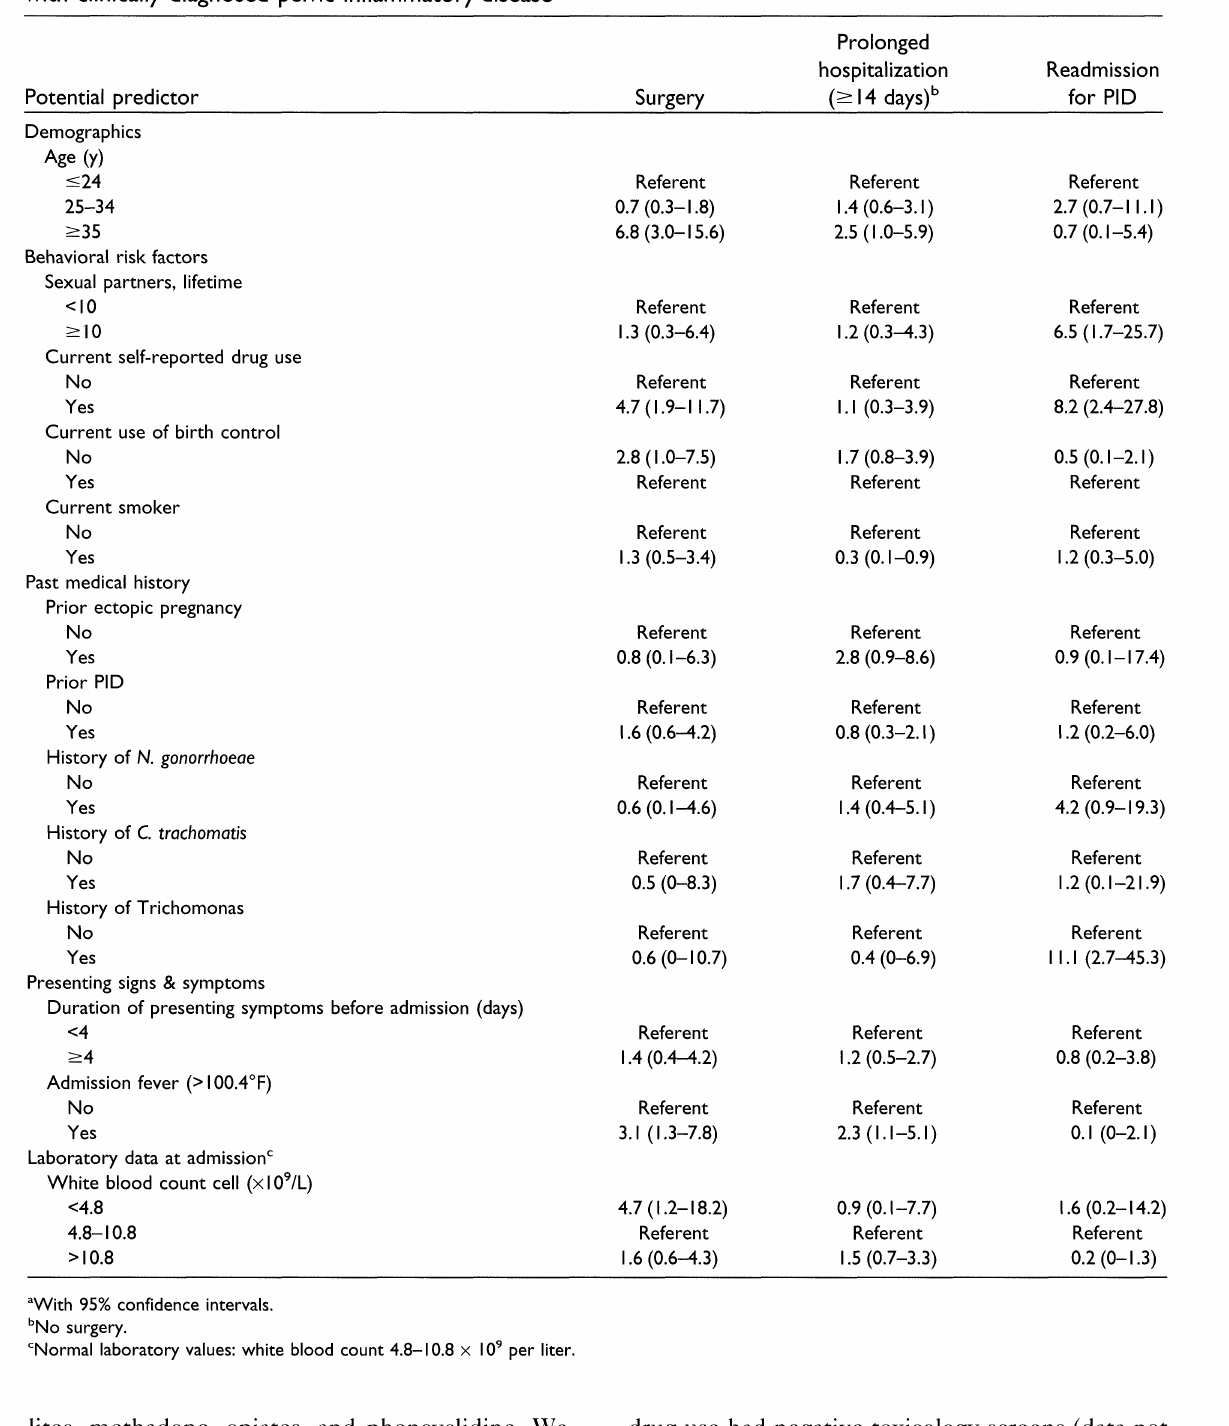
TABLE 2. Unadjusted odds ratios for complicated course by potential predictors among HIV-negative women with clinically diagnosed pelvic inflammatory disease